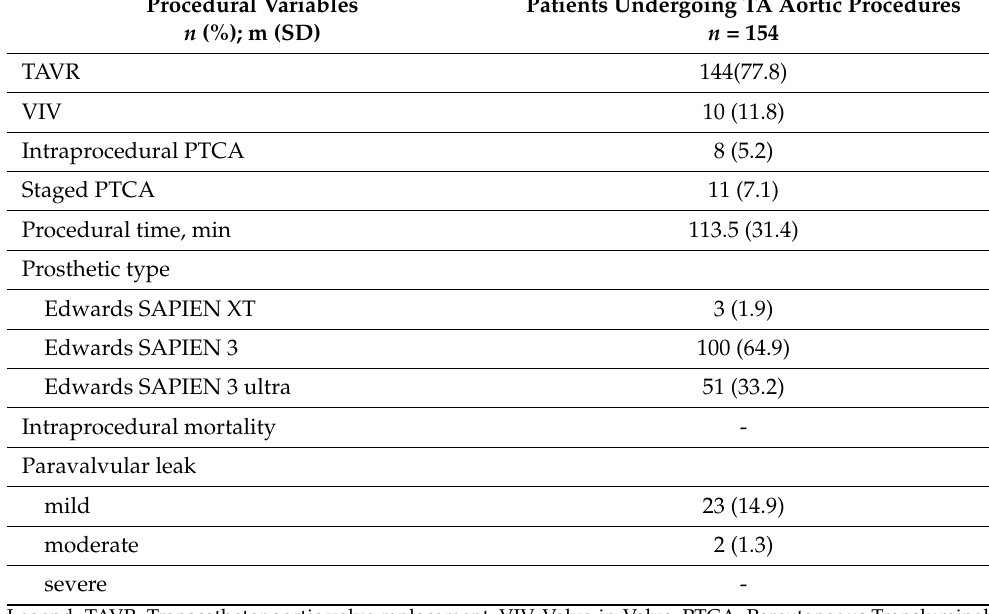
Figure 1. Transapical aortic procedures performed annually from January 2015 to April 2022. Table 2. Intraprocedural